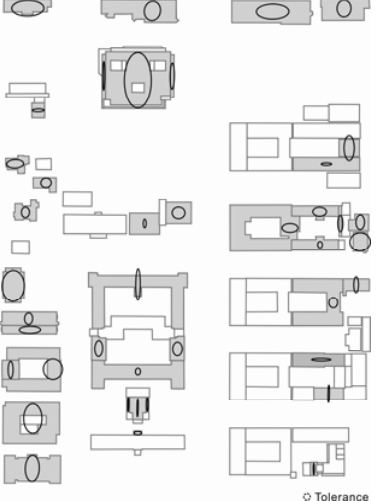
Figure 7. Incorrect building models (gray polygons) in the test